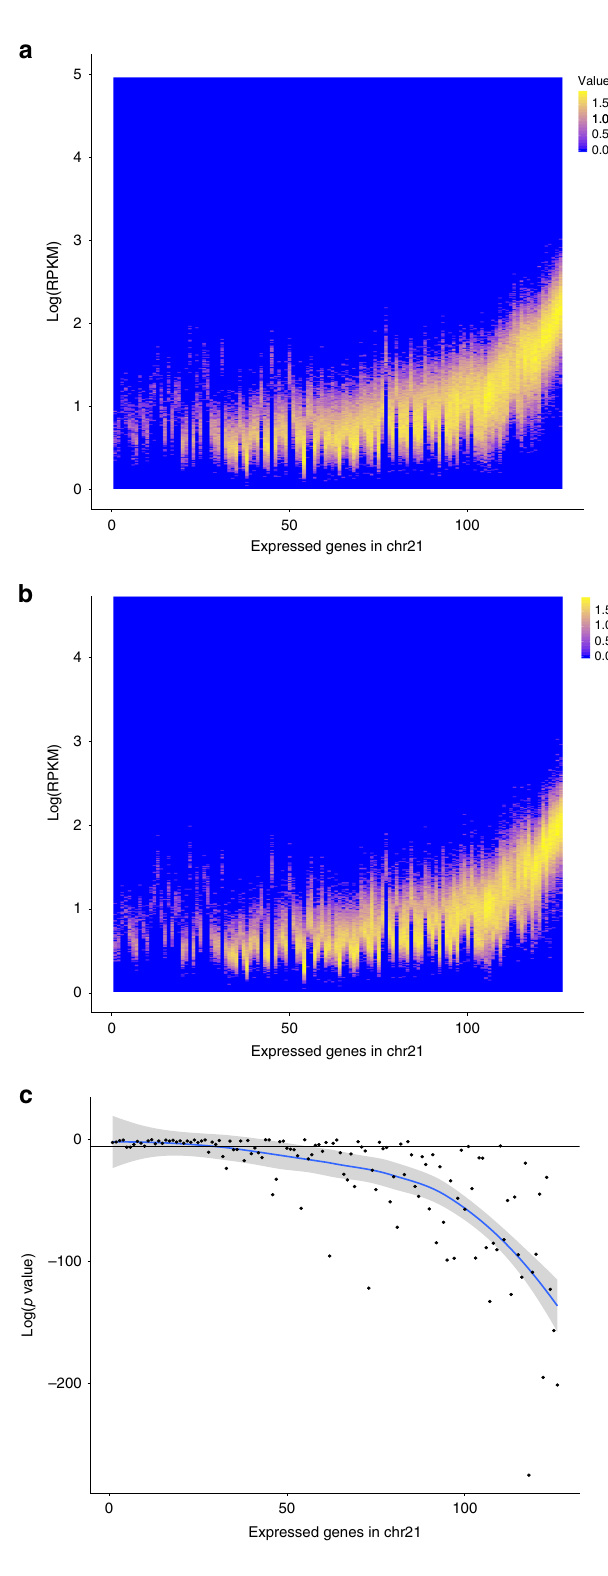
The theoretical application of the 2-state burst-like transcrip- tional model to trisomies provides an explanation of these observations (Eq. (1)). For average and highly expressed genes (i.e., housekeeping and maintenance of cell function), transcrip- tional bursting events are frequent in both diploid and trisomic